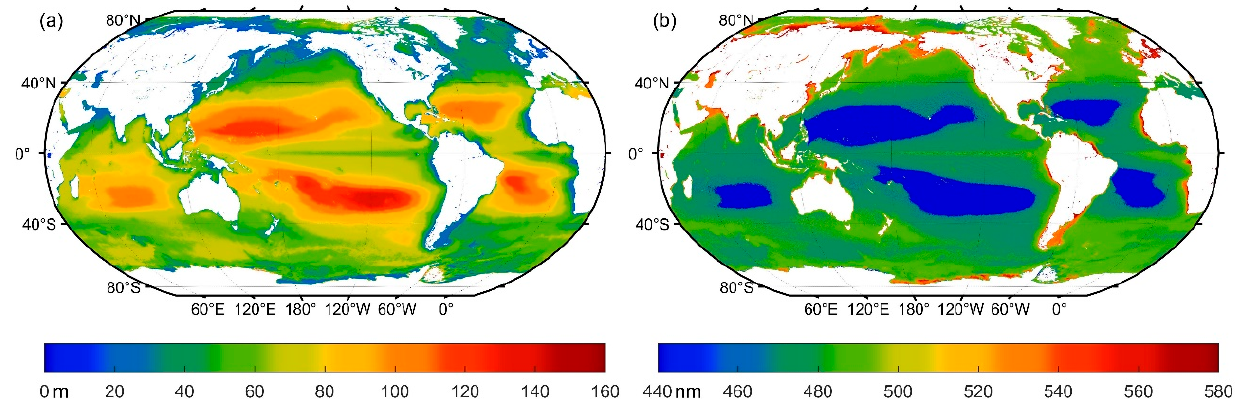
Figure 10. Global distribution of lidar maximum detectable depths ( a ) and corresponding optimal laser wavelengths ( b ).